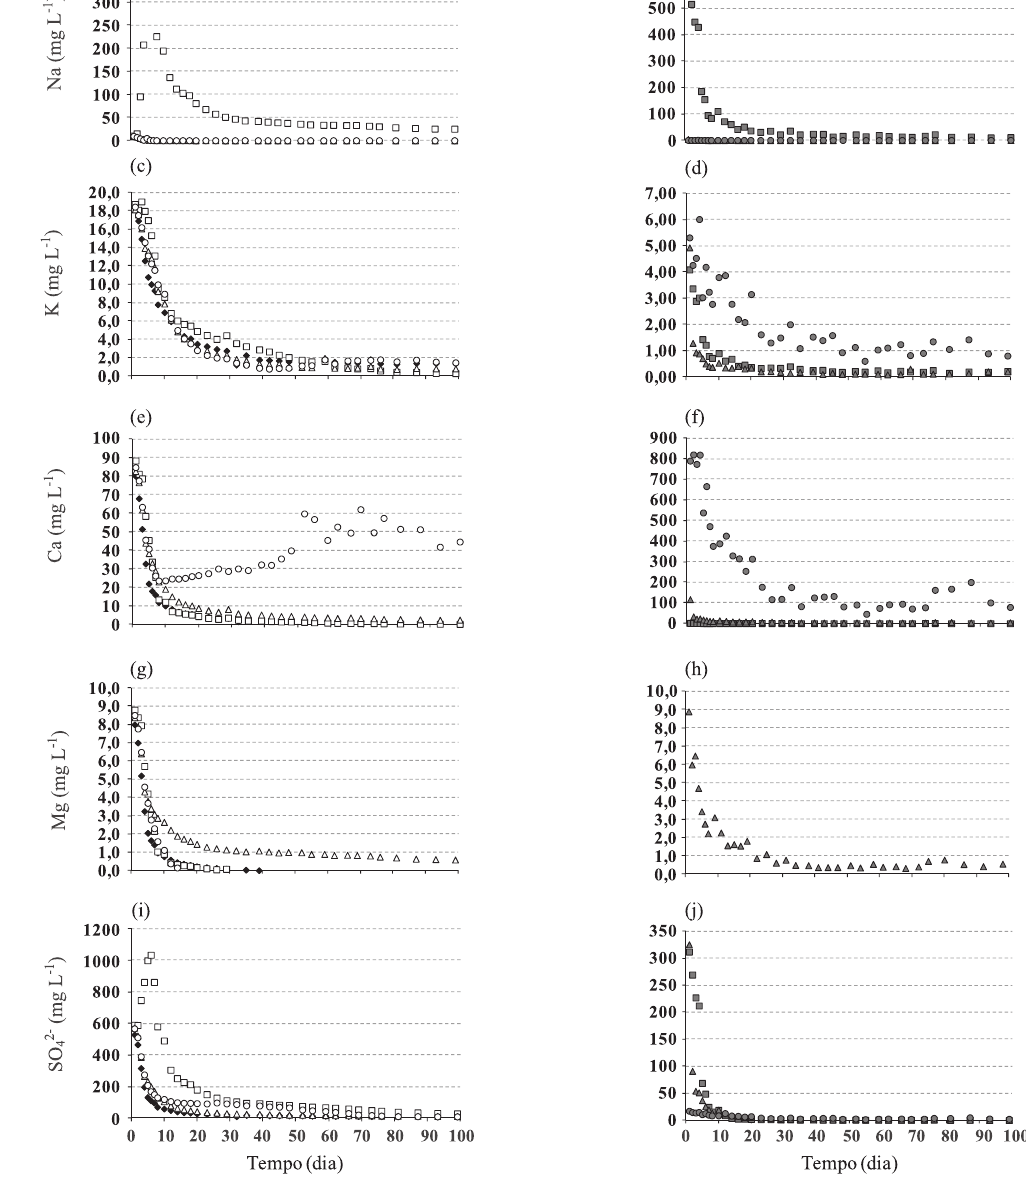
Figura 3. variações de elementos maiores (na, K, Ca e mg) e de sulfato nas águas lixiviadas ao longo do